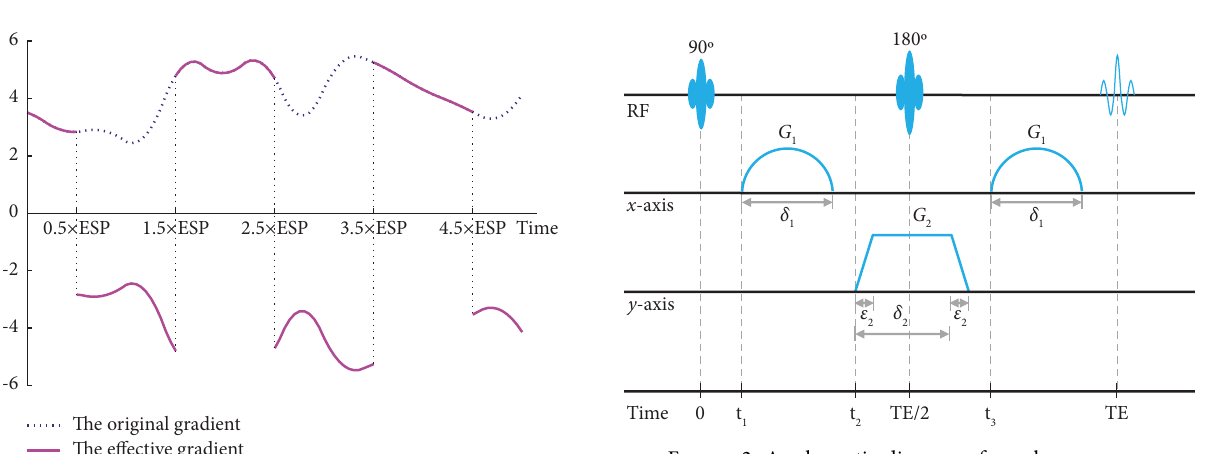
Figure 2: A schematic diagram of a pulse sequence.